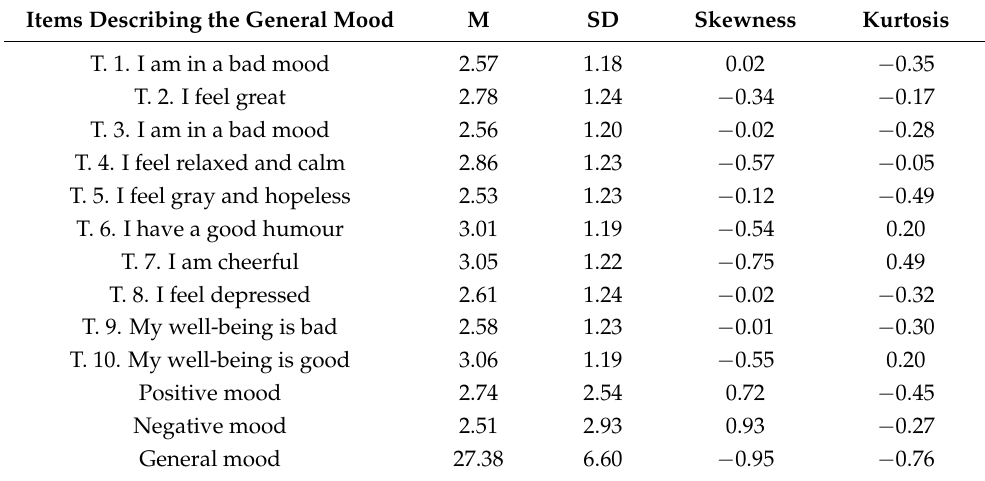
Table 4. Descriptive statistics for the General Mood Scale in the group of inmates (N =